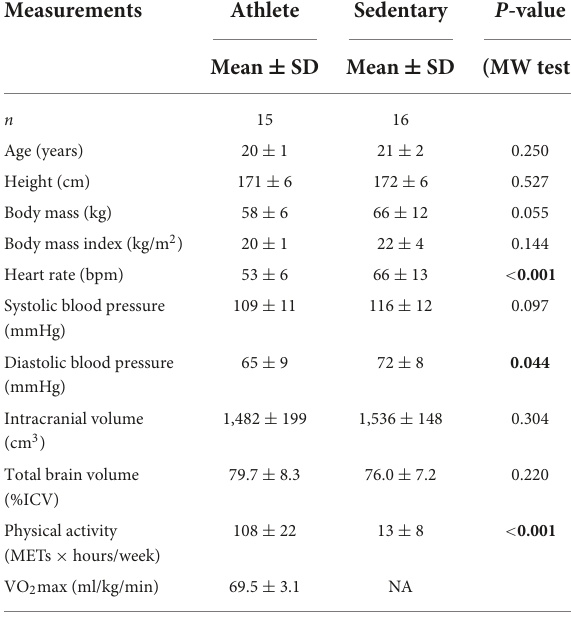
TABLE 1 Characteristics of the athlete and sedentary